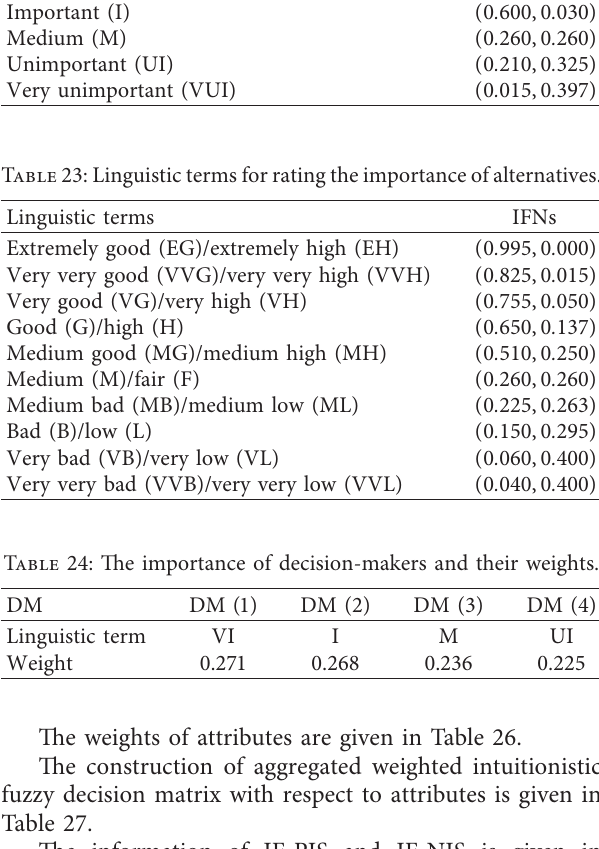
Table 22: Importance weight as linguistic variable. Linguistic terms IFNs Very important (VI)